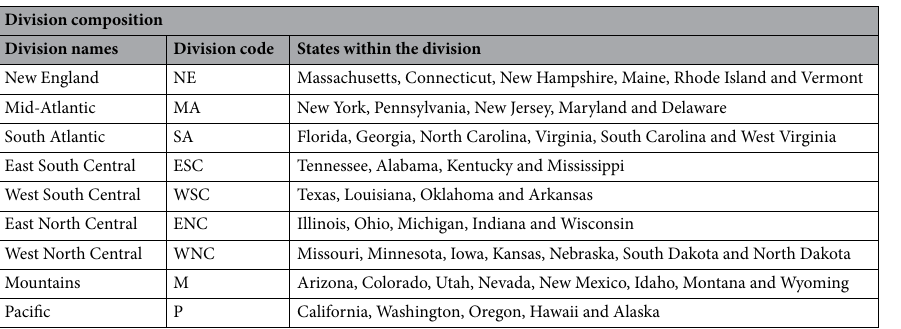
Table 1. States of the US integrated into 9 divisions. Maryland and Delaware are moved from South Atlantic to